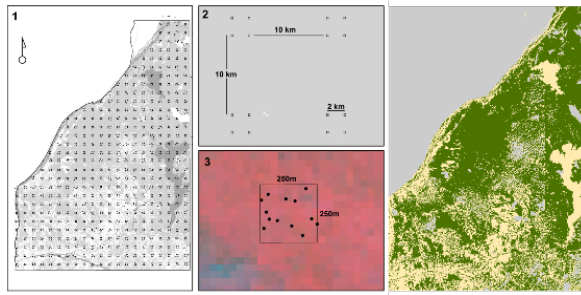
Figure 4. Overview of the training samples (1, 2 and 3) used for production of RapidEye FNF map for 2012 (Fig. 5).